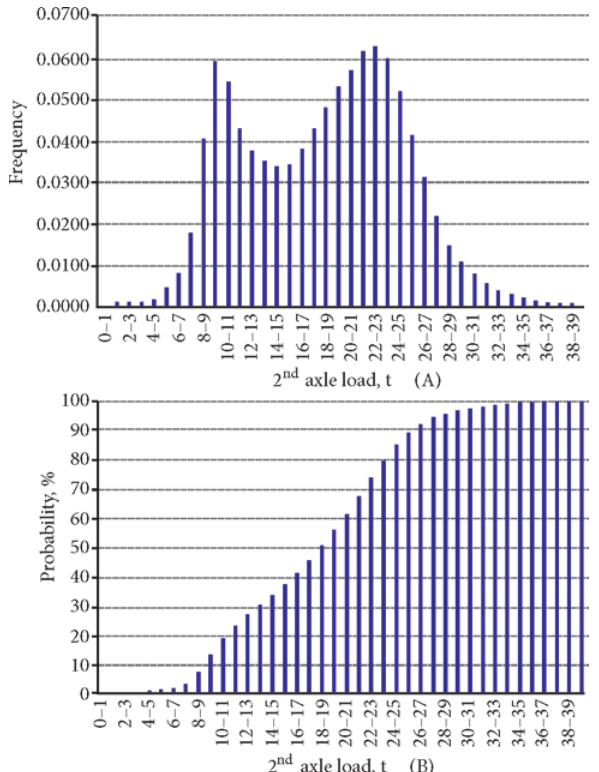
Fig. 5. The 5-axle vehicles of the 2 nd axle load frequency (A) and the accumulative probability distribution